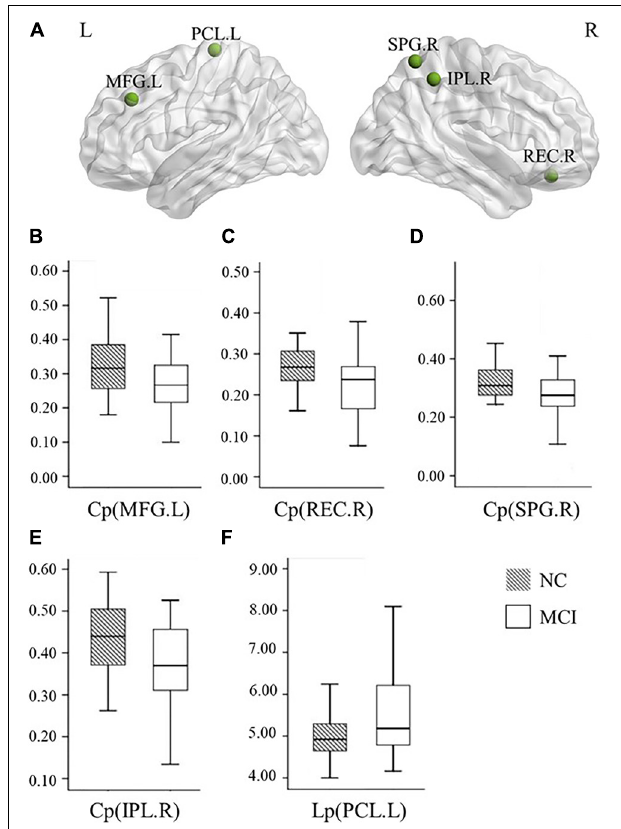
FIGURE 1 | Graphs show differences in the nodal network topological properties between the patients with MCI and normal controls. (A) The location of the node with significantly altered nodal network topological properties in MCI patients, compared with normal controls. (B–E) The nodal clustering coefficients in the left MFG ( p = 0.020), right REC ( p = 0.023), right SPG ( p = 0.034), and right IPL ( p = 0.009) were significantly different between the patients with MCI and normal controls. (F) The nodal shortest path length in the left PCL ( p = 0.045) was significantly different between the patients with MCI and normal controls. NC, normal controls; MCI, mild cognitive impairment; L, left; R, right; Cp, local clustering coefficient; Lp, local shortest path length; MFG, middle frontal gyrus; REC, rectus; SPG, superior parietal gyrus; IPL, inferior parietal gyrus; PCL, paracentral